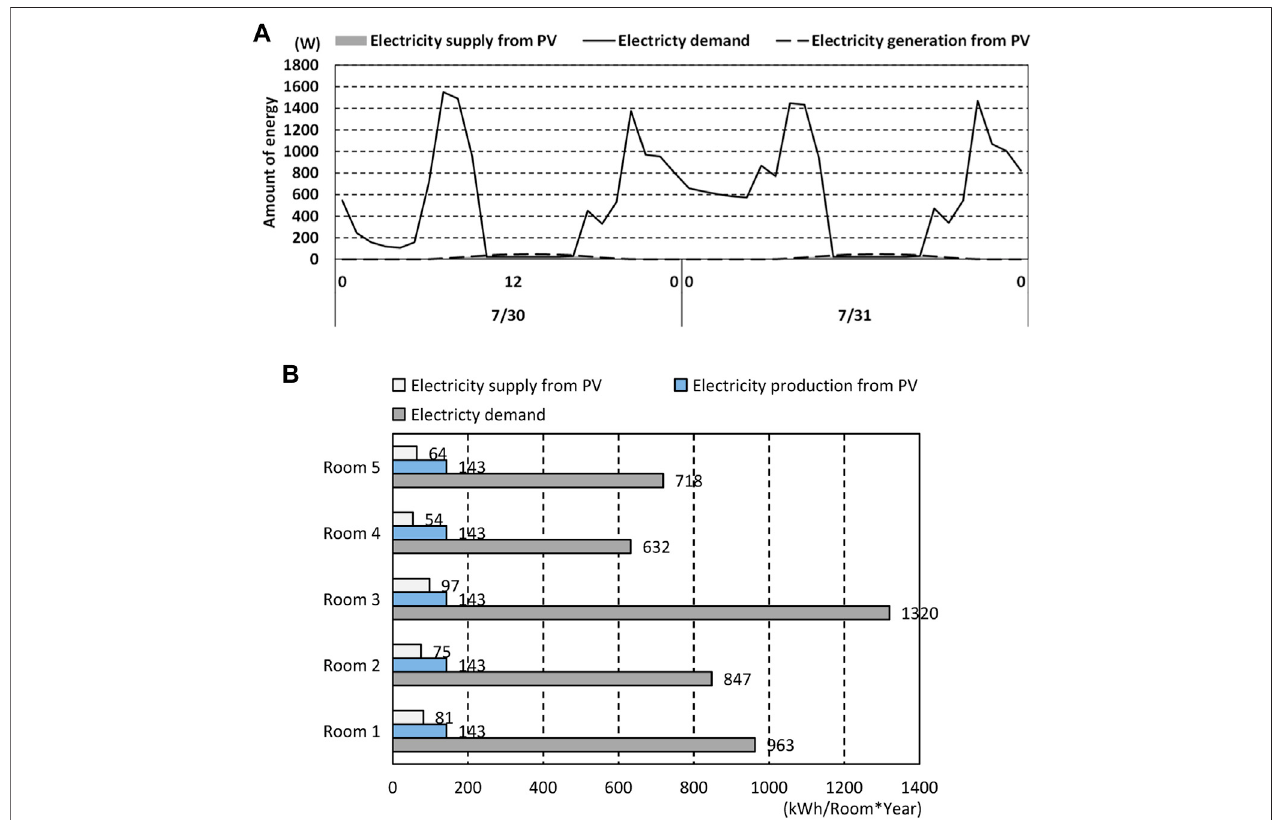
FIGURE 7 | Energy performance of only using a 1.3-m 2 PV system in each room: (A) PV simulation results for Room 3, (B) annual electricity demand, and PV system generation and supply.